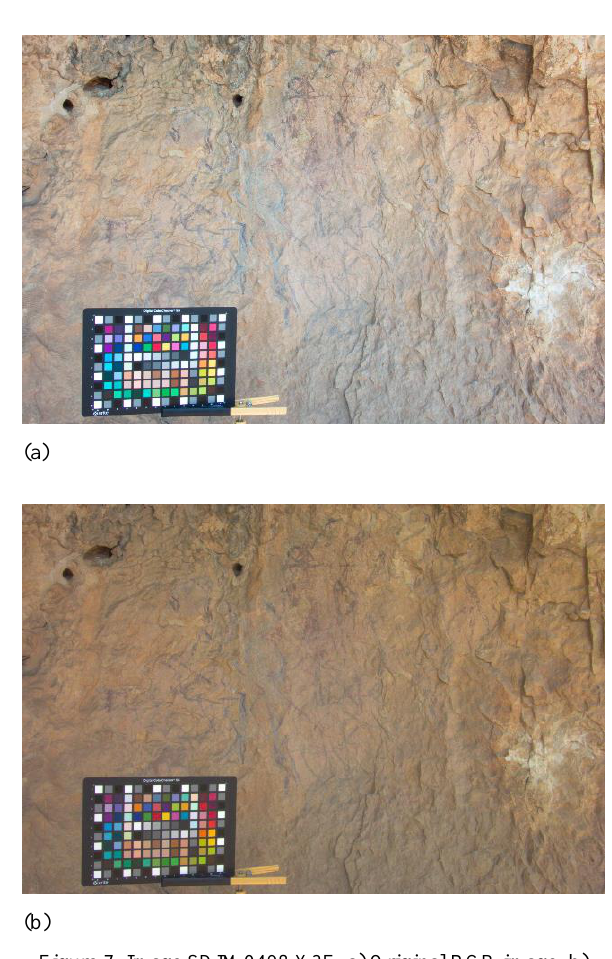
Figure 7. Image SDIM0498.X3F: a) Original RGB image; b) sRGB output